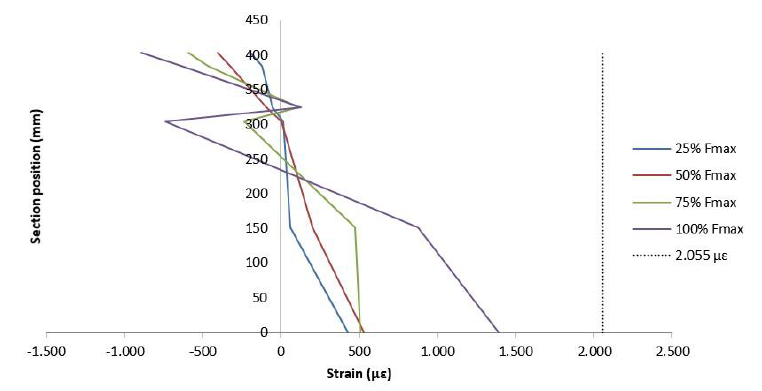
Figure 21. Strain distribution curve –